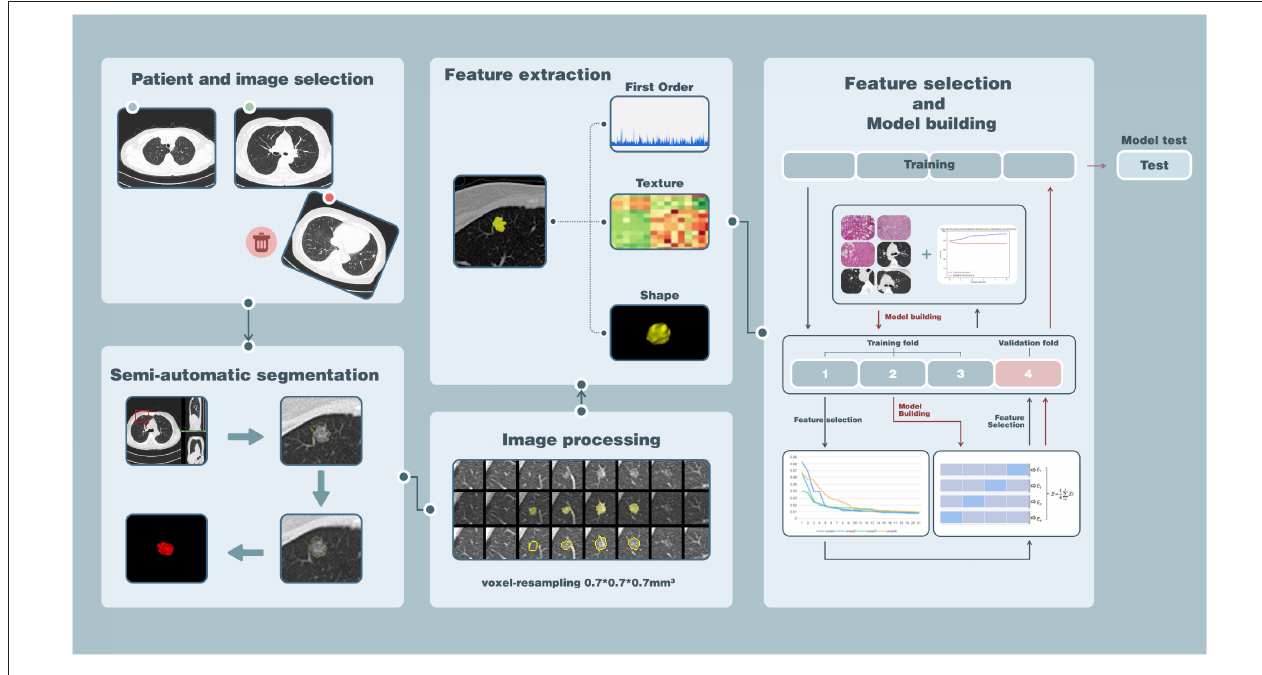
FIGURE 2 | The flowchart of the whole study.